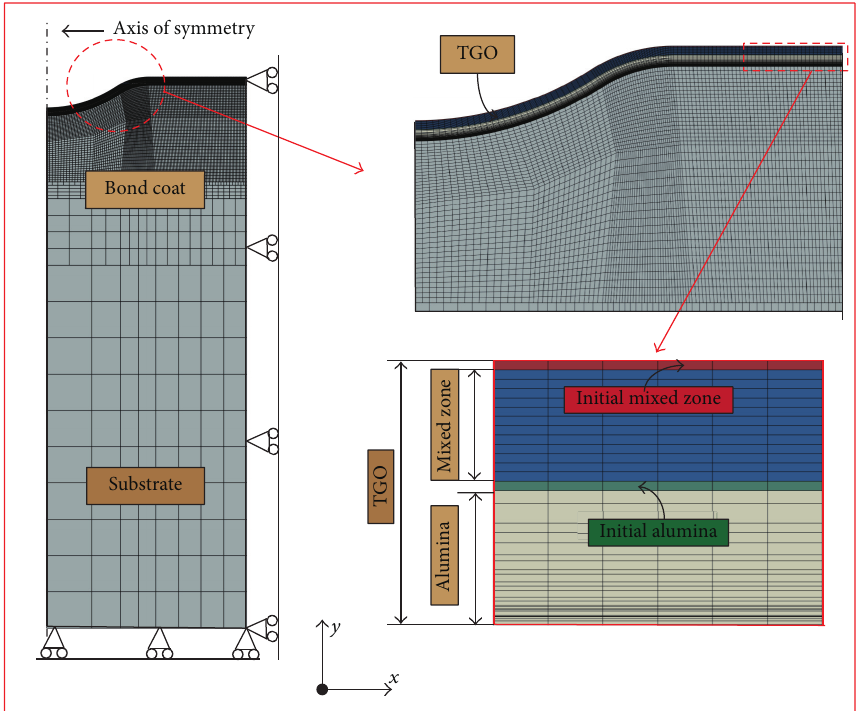
Figure 1: The geometry and boundary conditions used in the FE model analysis.